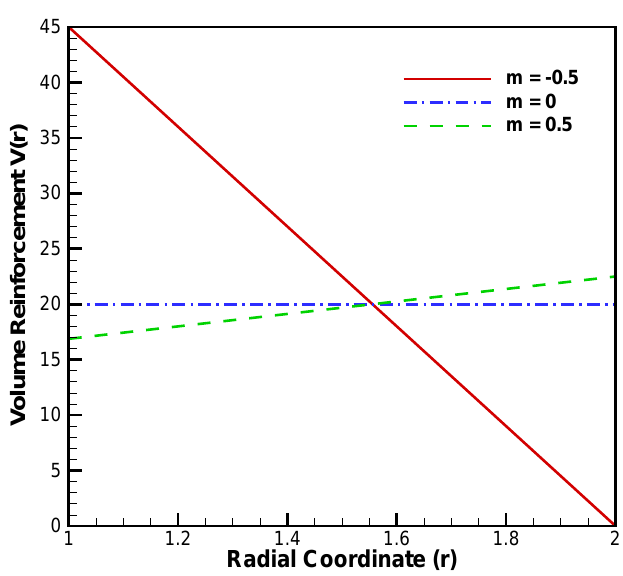
Figure 11. Linear volume reinforcement (vol %) of SiC p in Al metal matrix along the radius r (in cm) of the